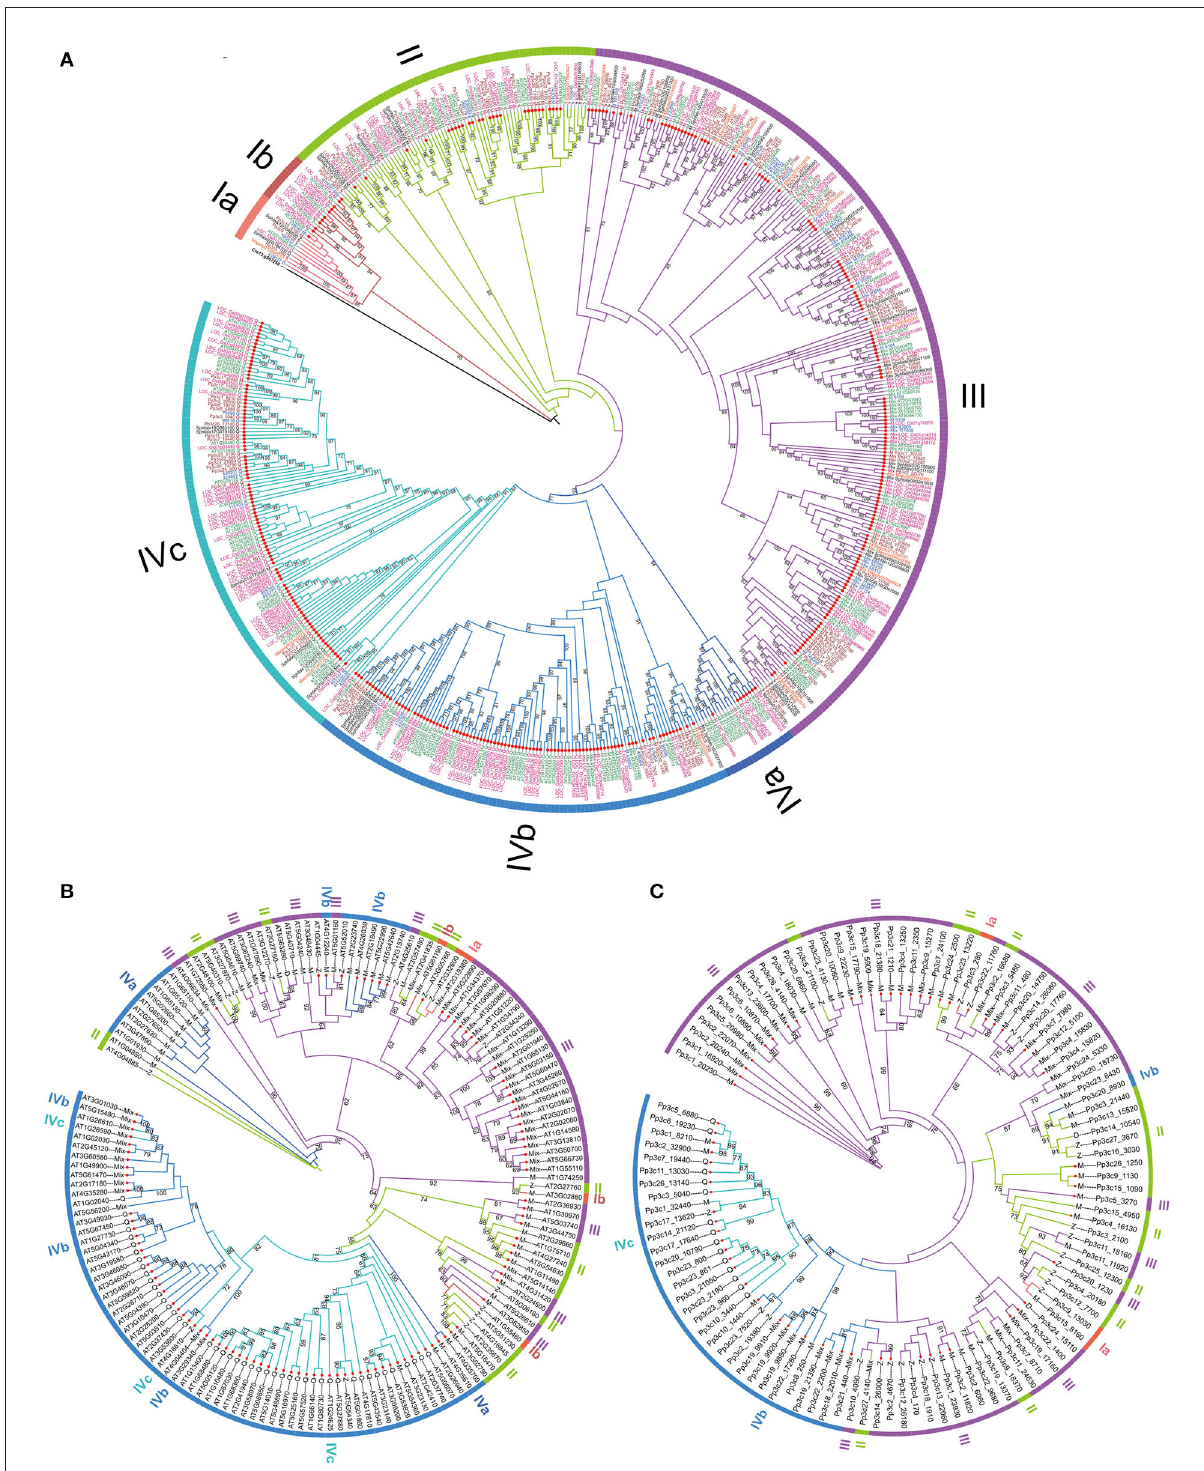
FIGURE4 Phylogeny of C2H2-ZFPs. (A) Phylogeny of 549 identified C2H2-ZFPs. (B,C) Phylogeny of PpZFPs and AtZFPs. The trees were constructed by iqtree 1.0 software using maximum likelihood (ML) method with 1,000 bootstraps. The C2H2-ZFPs containing only C2H2 domain are marked with small red